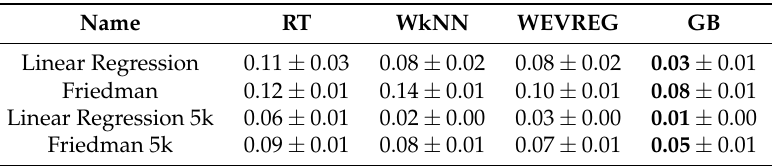
Table 4. MAE on synthetic datasets (the lower the